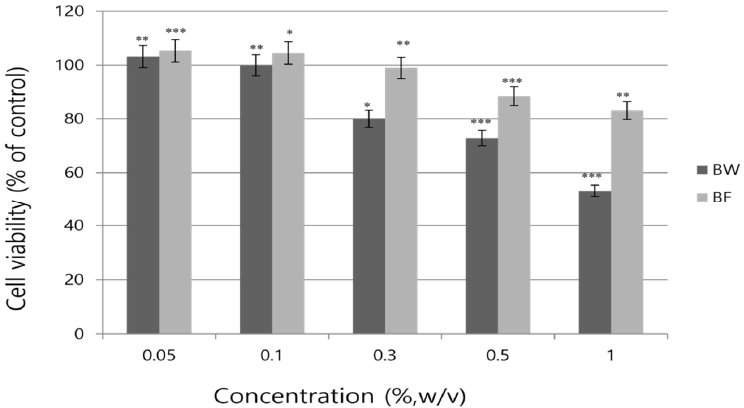
Figure 2. Cell cytotoxicity of the aloe skin leaf extracts from two different processes against murine melanoma cells. BW: Water extract of aloe skin leaf at 100 ◦ C for 24 h. BF: Fermented extract of aloe skin leaf fermented with L. plantarum BN41 at 37 ◦ C for 3 days and further extracted by an ultrasound generator at 20 kHz for 4 h. The mean values ± SD for separate triplicate experiments are shown, and error bars represent the SD. Statistically significant value was calculated by comparing with each group (* p < 0.05, ** p < 0.01 and *** p < 0.001).